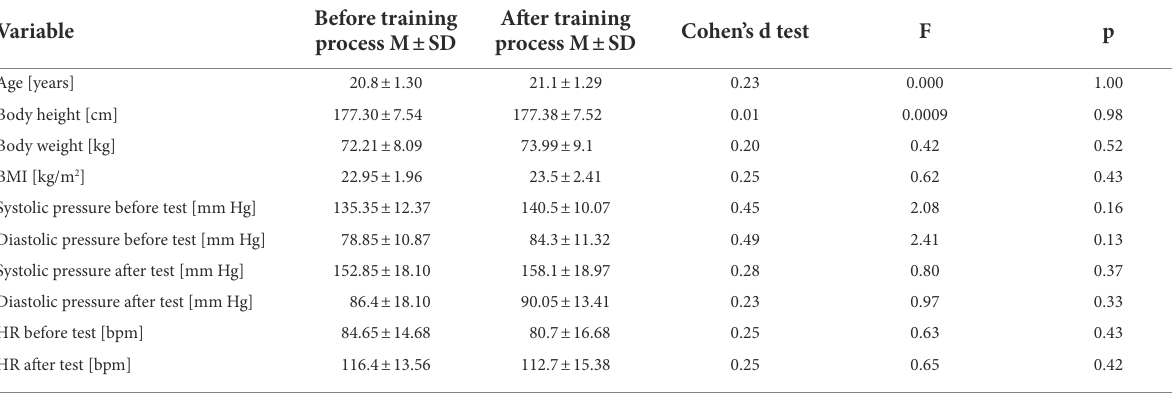
TABLE 2 Difference in somatic data and in hemodynamic parameters during the psychomotor test before and after the training process of cadet pilots ( n = 20). Variable